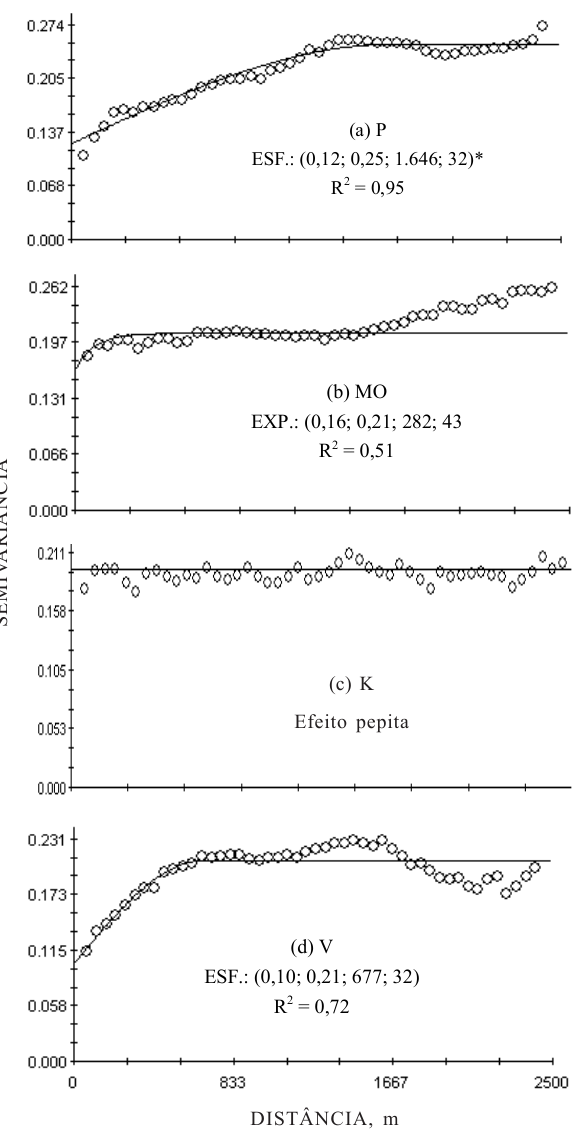
Figura 2. Semivariogramas das variáveis indicadoras, quando se utilizaram, como valores de corte, os valores do 1 o quartil: (a) fósforo; (b) matéria orgânica; (c) potássio e (d) saturação por bases. * MODELO: C ; Patamar (C + C); Alcance; C 0 0 0